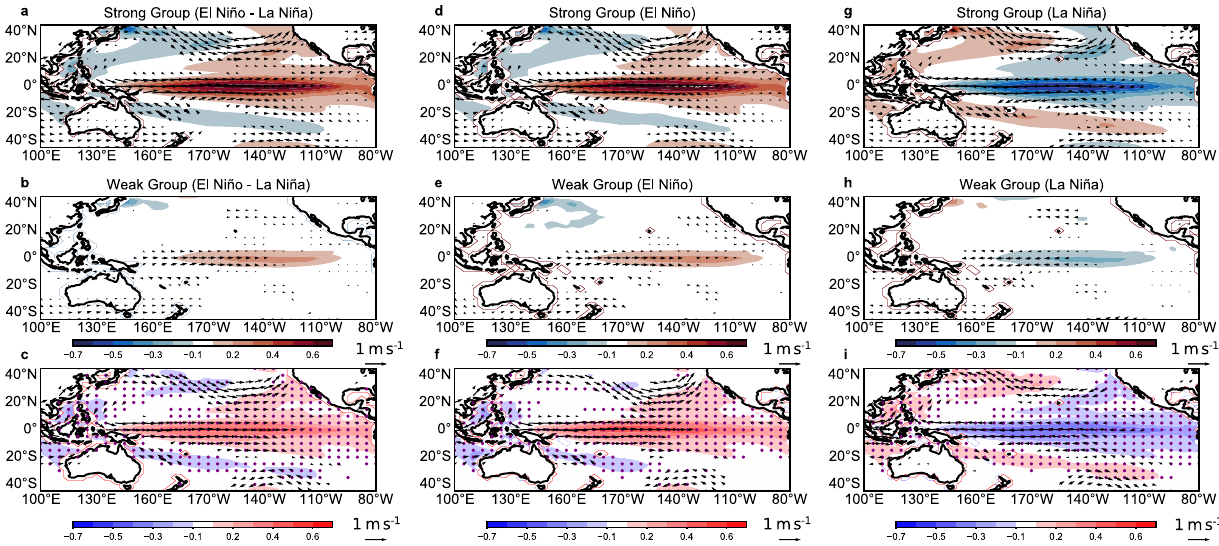
Fig. 7 Composite of subsequent D1JF2-averaged 850-hPa wind and SST anomalies for the strong and weak MWAF groups as well as the differences between groups. a , b Composite difference of subsequent D1JF2-averaged 850-hPa wind (unit: m s − 1 ) and SST (unit: °C) anomalies between positive and negative NPO phases for the strong and weak groups, respectively. c Differences of wind and SST anomalies between the strong ( a ) and weak ( b ) MWAF groups. d , e Composite of 850-hPa wind and SST anomalies during positive NPO phases for the strong and weak MWAF group, respectively. f Differences of wind and SST anomalies between the strong ( d ) and weak ( e ) MWAF groups. g – i Same as ( d – f ) but for negative NPO phases. The dots represent areas above the 90% con fi dence level for the SST, and the vectors are shown only with the zonal wind above the 90% con fi dence